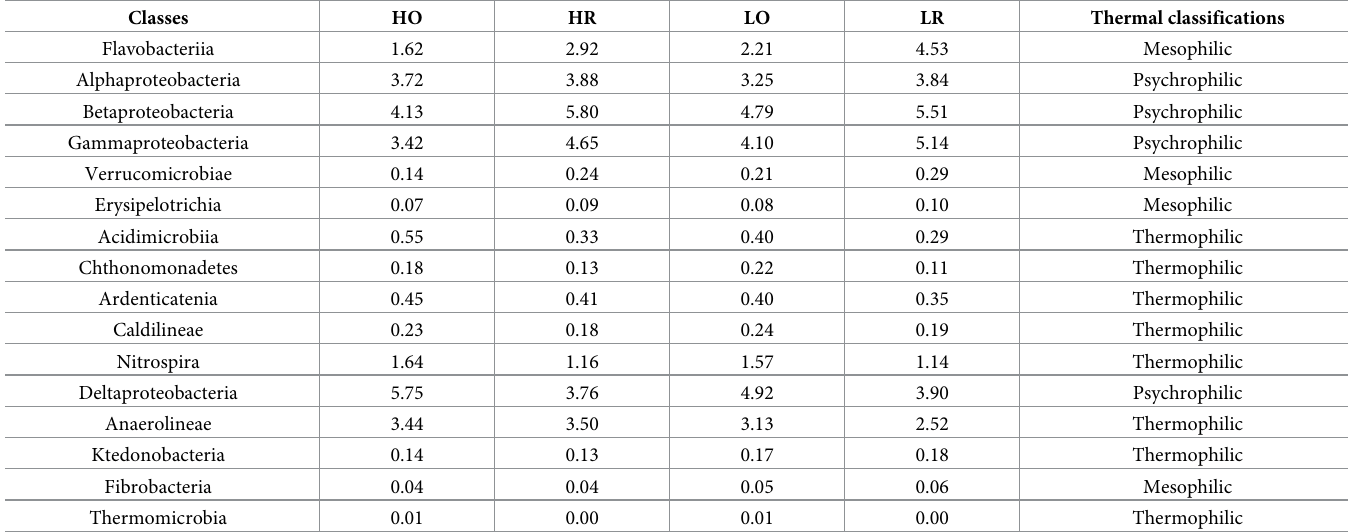
Table 4. Relative abundance (%) of classes under different fertilizer treatments.